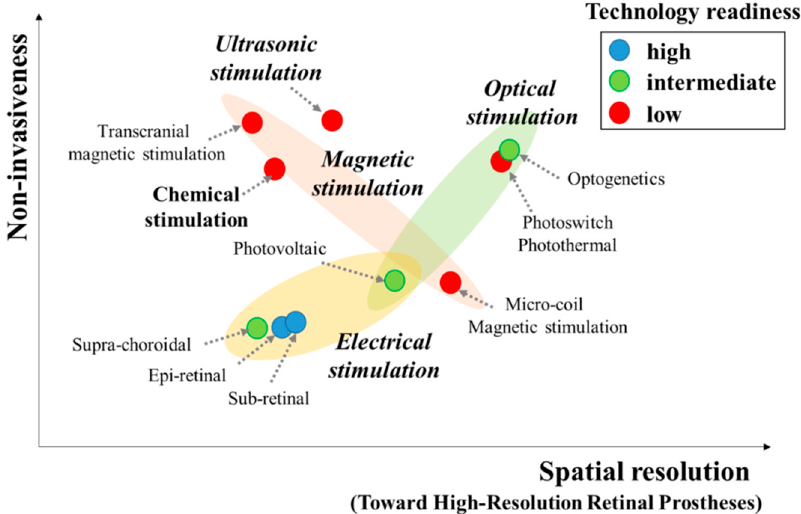
Figure 3. A two-dimensional representation comparing spatial resolution and invasiveness of various retinal prosthetic approaches discussed in this article, along with color-coded description on technology readiness.